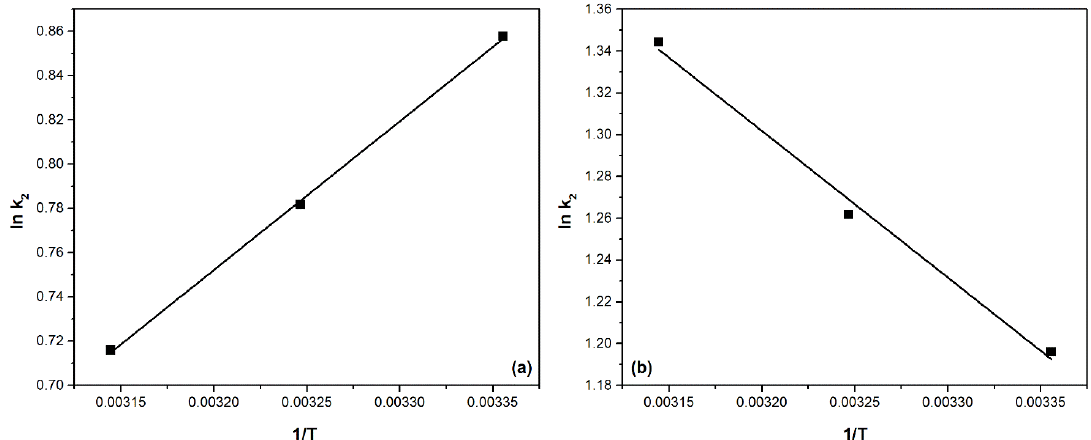
Figure 13. Activation energy for the Pd(II) adsorption process on the two studied materials: ( a ) MgSiO 3 -DB18C6, ( b ) MgSiO 3 -DB30C10.